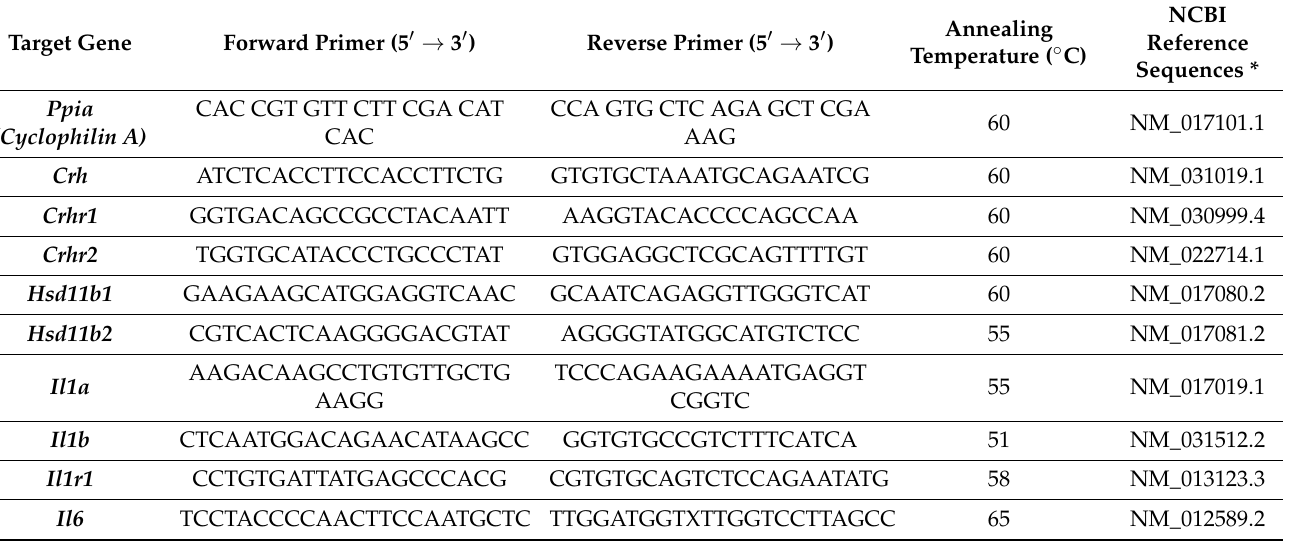
Table A3. Primer forward and reverse sequences and annealing temperatures for